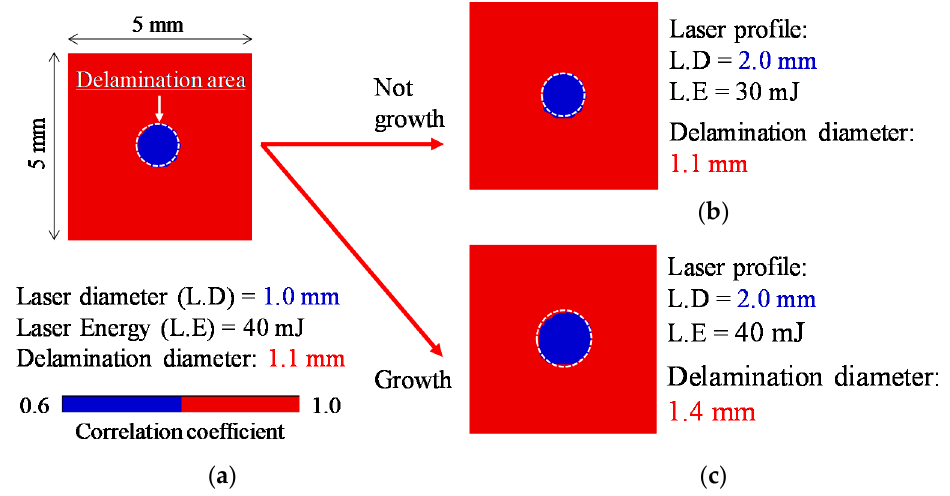
Figure 4. Visualization of delamination area by LUS. ( a ) is initial delamination and ( b , c ) is result of additional LaSAT. Note that ( b ) shows no delamination growth and ( c ) is delamination growth.